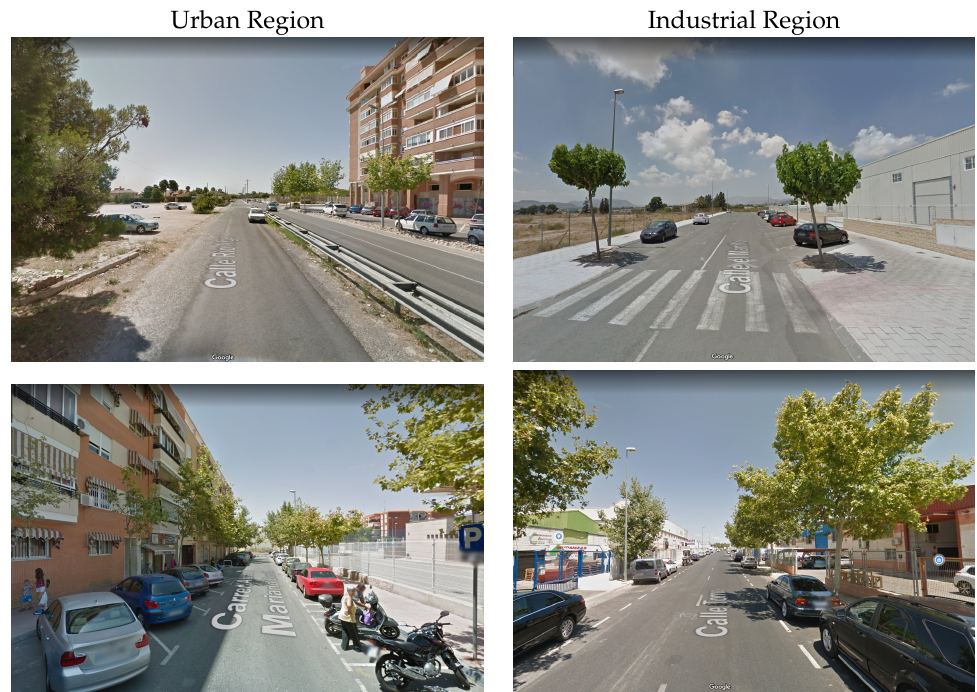
Figure 26. Similar images belonging to different areas in the city that were clustered together. The left-hand images were captured in an urban region of the city, whereas the right-hand images were obtained in the industrial